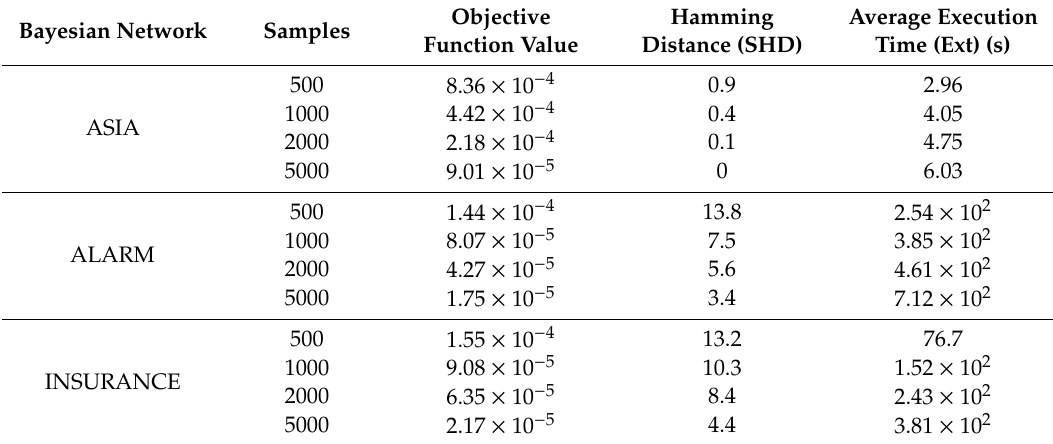
Table 3. Bayesian network structure learning method based on discrete multi-group artificial bee colony algorithm based on cuckoo algorithm (CMABC-BNL) experimental results.